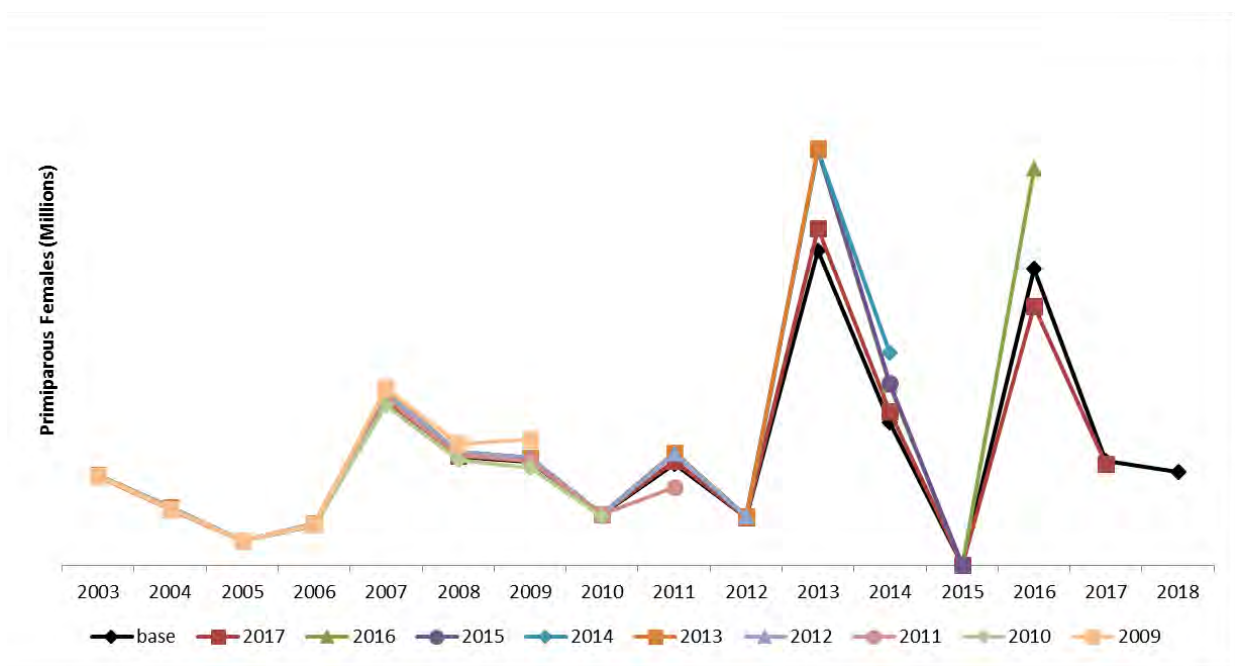
Figure 110. Retrospective peel of estimated primiparous abundance to 2009. Y-axis values have been removed due to CONFIDENTIAL data.